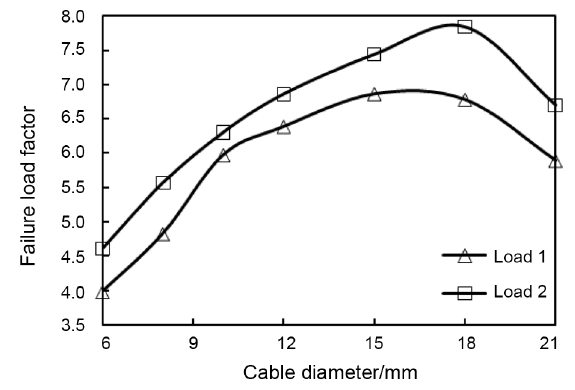
Fig. 15. Failure loads with different areas of